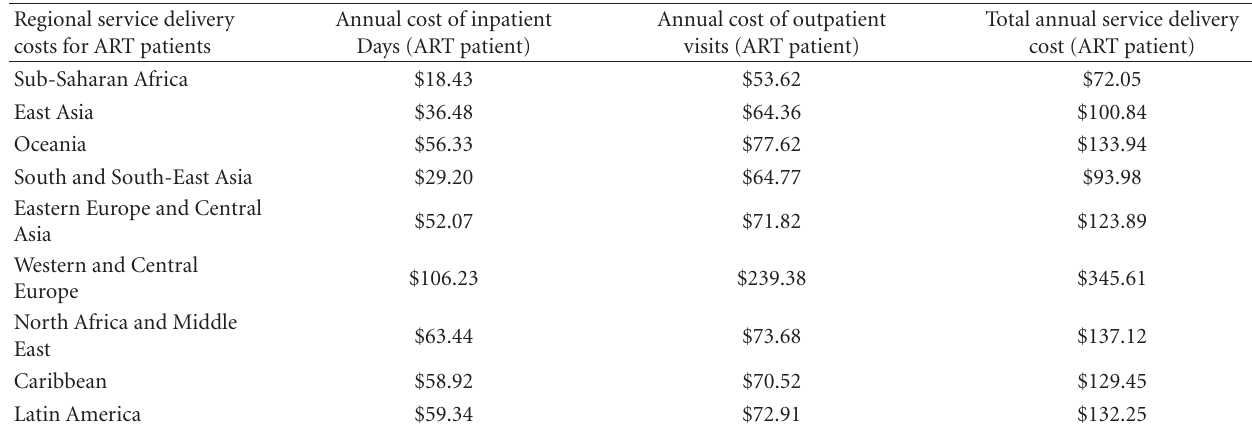
Table 2: Representative service delivery costs by region.